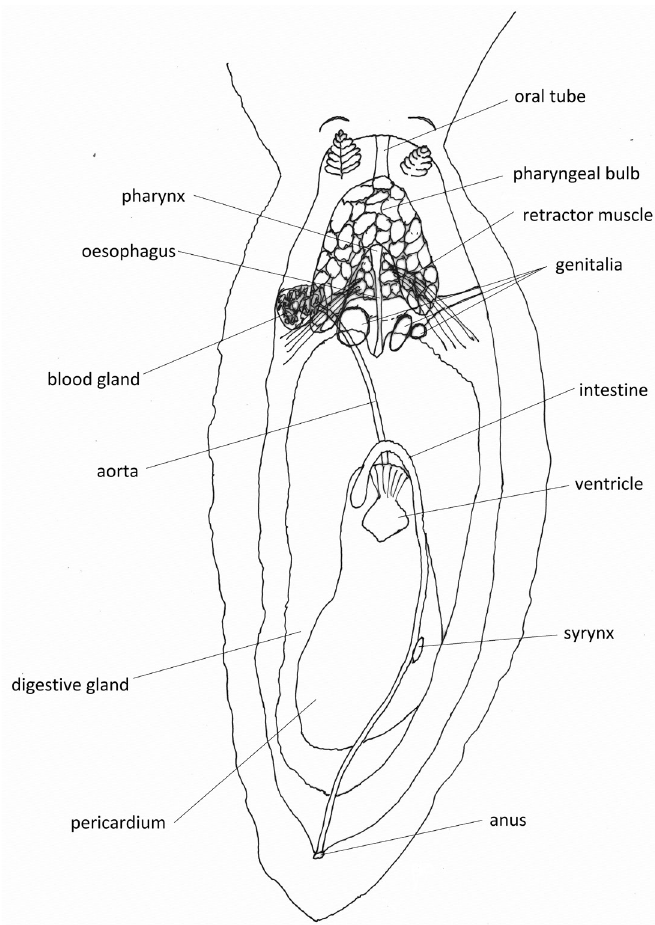
Figure 8. Phyllidia schupporum , drawing of the digestive anatomy, also showing the genitalia (in heavier ink). is one large tubercle just behind the rhinophores followed by two more. These three tubercles are the largest and rugose, with the basal pustules faintly tipped in yellow pigment which deepens towards tips. The white anal papilla is located just behind the third dorsal tubercle and located in a white area; the anal opening is surrounded by tiny black spots. There is one smaller white and yellow pustulose tubercle behind the anal papilla (far right on Plates 9, 11, 13). The deep yellow rhinophores are almost parallel sided with a short tip (Plates 9, 11, 14). They are each set in a tapering white patch with a yellow rhino-tubercle just behind and slightly displaced laterally. The rhinophores have 16–20 lamellae (counted from photographs). The preserved specimen is black and white (Fig. 7A). Both the black and white areas are pimpled with small pustules, which are more obvious on the white areas. The tubercles are very unusual for species of Phyllidia and in preservative resemble the tubercles of Dendrodoris tuberculosa (Quoy & Gaimard, 1832). They are composed